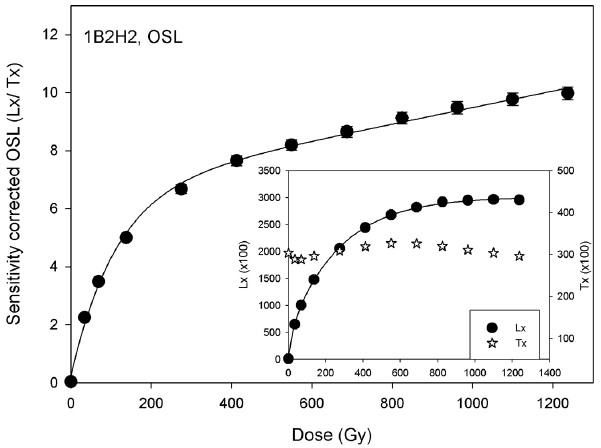
Fig. 2. Saturation dose curve of sample Elgy1B2H2 fitted to a single exponential plus linear function. The standard SAR protocol was applied with 12 dose steps up to a maximum beta dose of 1237Gy. Up to about 400Gy the dose response signal is best fitted to an expo- nential function and then beyond to a linear function up to 1237Gy. The inset shows the deconvoluted L x /T x . The background sub- tracted OSL regenerative curve is in saturation but a decreasing test dose signal results in a linear increase of the dose response